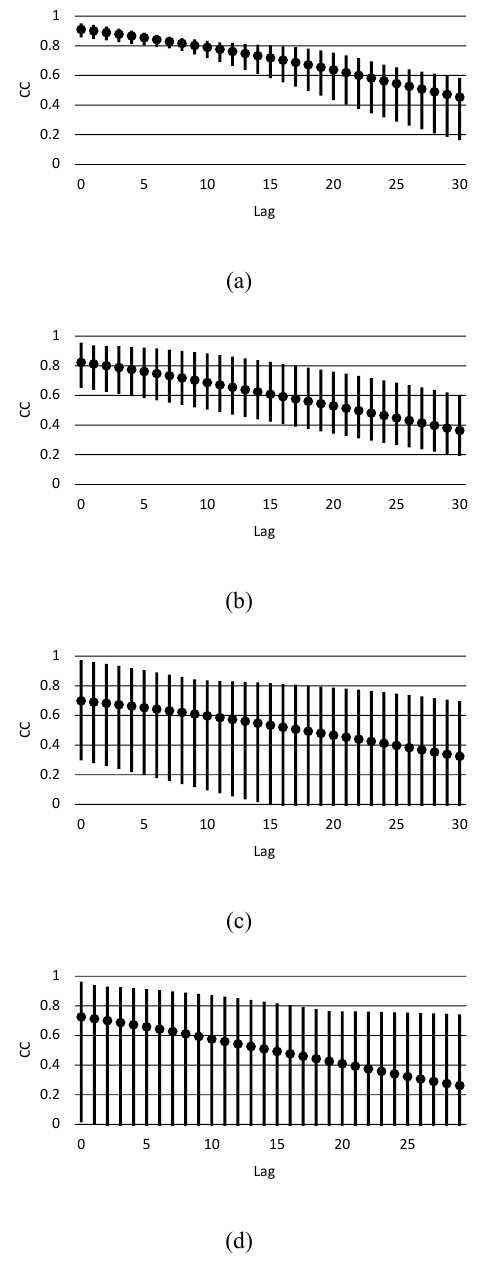
Figure 3. Correlations between water-level and cumulative rainfall over various durations: (a) Zhongnanxing station; (b) Xinnan sta- tion; (c) Sijie station; (d) Meifu station.